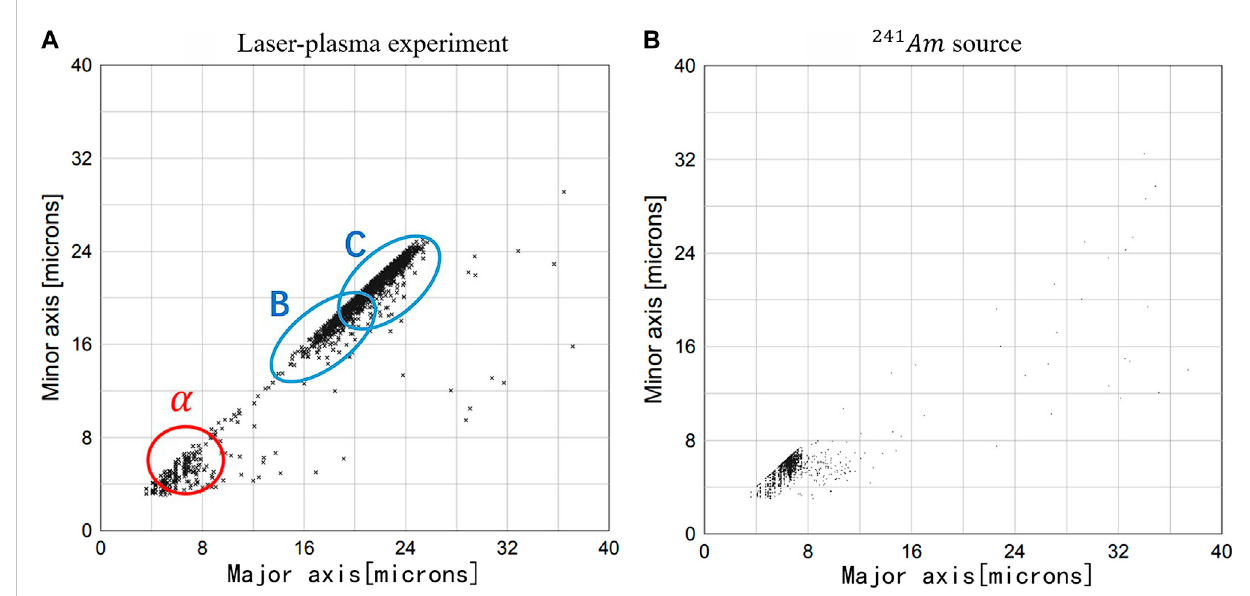
FIGURE 6 Diameter (minor and major axis) distribution of tracks on CR-39 surface. The blue encircles tracks group of 11 B or 12 C , and the red encircles tracks (and background impurity) of α in (A) . α particles recorded by CR-39 from an 241 Am source (B) .